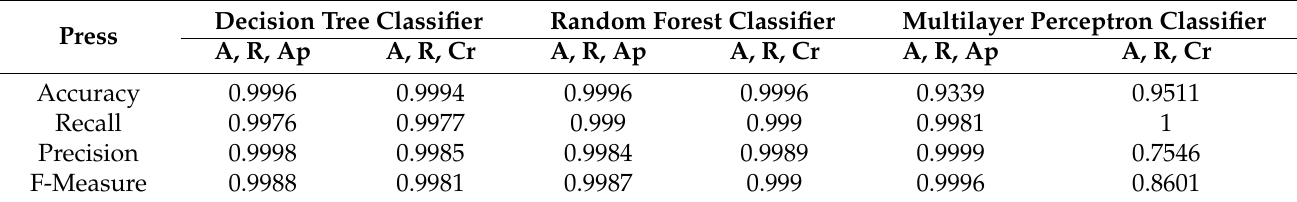
Table 7. More results from the press’ classifiers with various subsets of features used for training. With “A, R, Cu, Cr, An” we denote the features active power, reactive power, RMS current, Crest factor, and Angle between V and I .